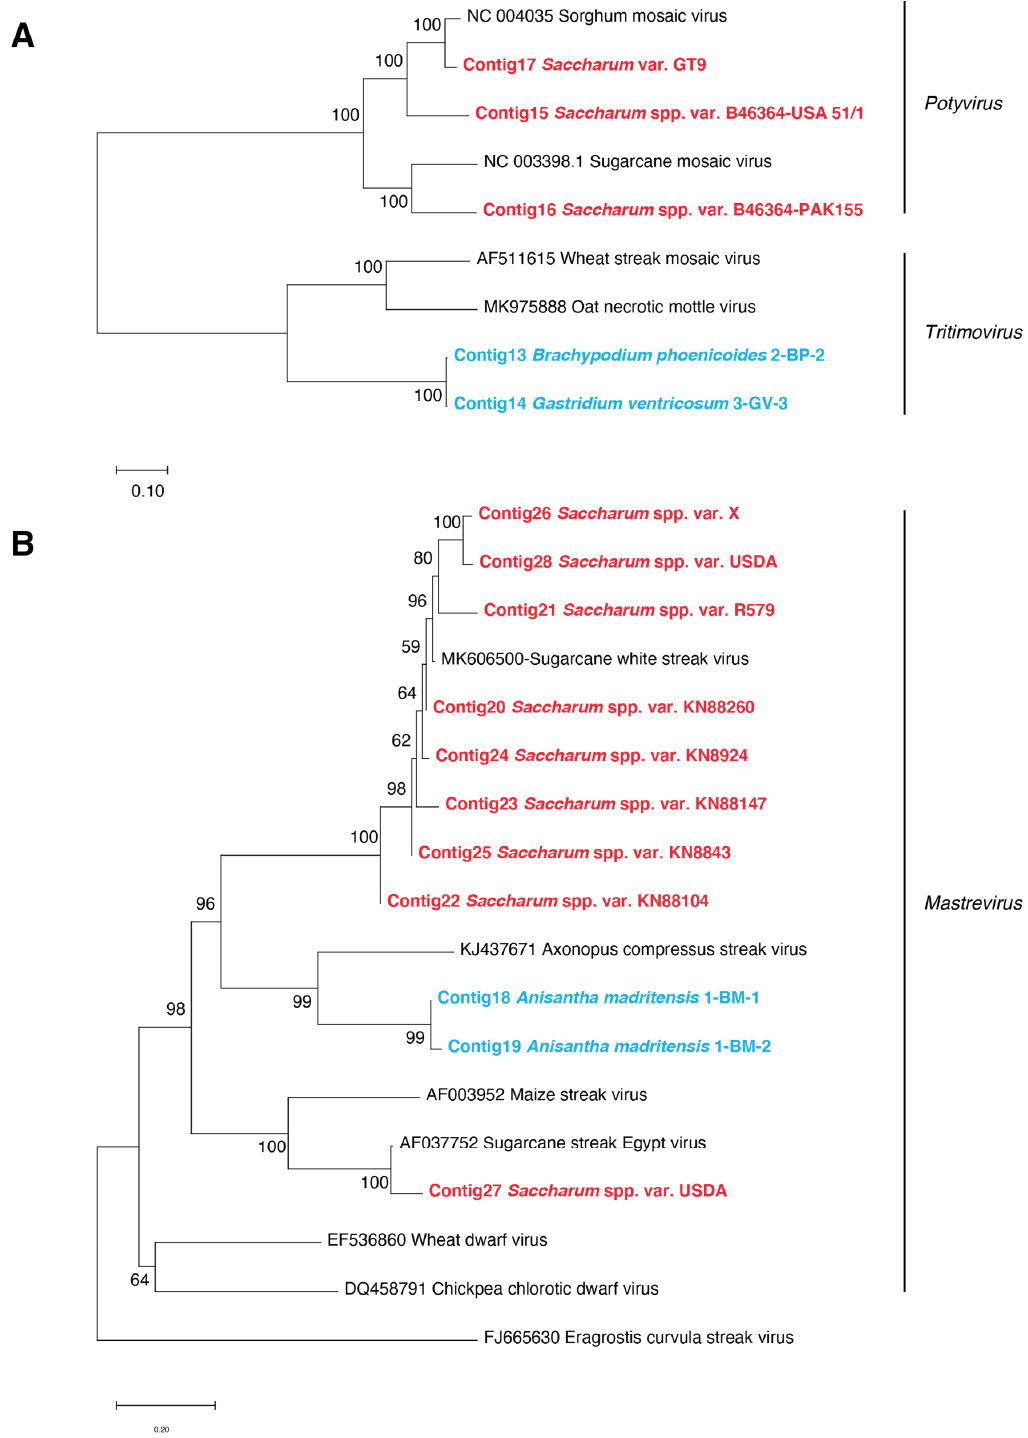
Figure 3. ( A ) Neighbor-joining phylogenetic tree of Potyviridae contigs obtained from wild Poaceae (bold characters colored in blue), sugarcane varieties (bold characters colored in red), and representative potyviruses and tritimovirus genome sequences (colored in black). ( B ) Neighbor-joining phylogenetic tree of Geminiviridae contigs obtained from wild Poaceae species (bold characters colored in blue), sugarcane varieties (bold characters colored in red), and representative mastrevirus genome sequences (colored in black). Scale bars represent the number of substitutions per site; branch labels correspond to the consensus support (%). The 16 contigs obtained from quarantined sugarcane varieties and wild Poaceae samples, assigned to the Potyviridae and Geminiviridae families, are listed in the Supplementary Material.